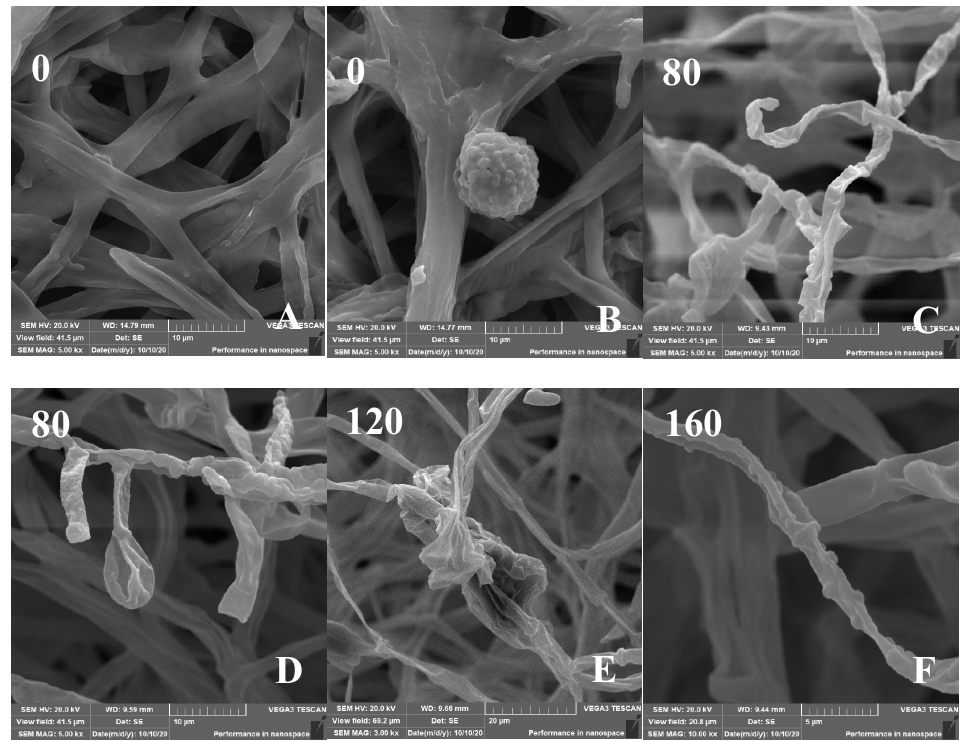
Figure 6. Scanning electron micrographs of H. chrysospermums grown for 7 days on PDA with grad- Figure 6. ( A – F ) Scanning electron micrographs of H. chrysospermums grown for 7 days on PDA ually increasing concentrations of Cd 22+ . Data of 0–160 in the figures indicate the Cd 2+ concentrations with gradually increasing concentrations of Cd 2+ . Data of 0–160 in the figures indicate the Cd 2+ in PDA (mg L − 1 ). concentrations in PDA (mg · L − 1